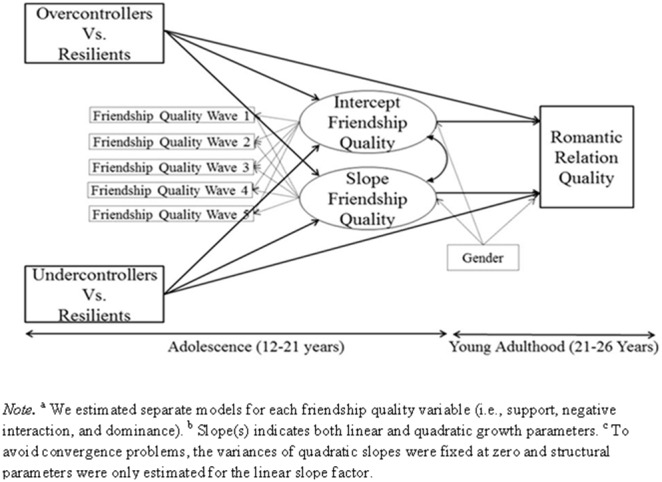
Structural Equation Model Testing the Relations between Adolescent Personality Types, Adolescent Friendship Quality Development, and Young Adulthood Romantic Relationship Quality.